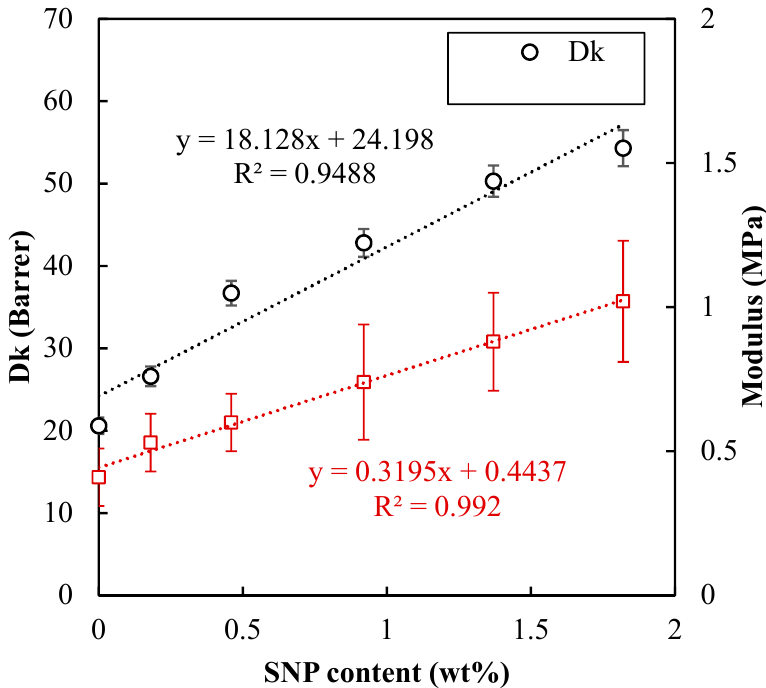
Figure 7. E ff ect of SNPs content on oxygen permeability and Young’ Figure 7. Effect of SNPs content on oxygen permeability and Young’ modulus.